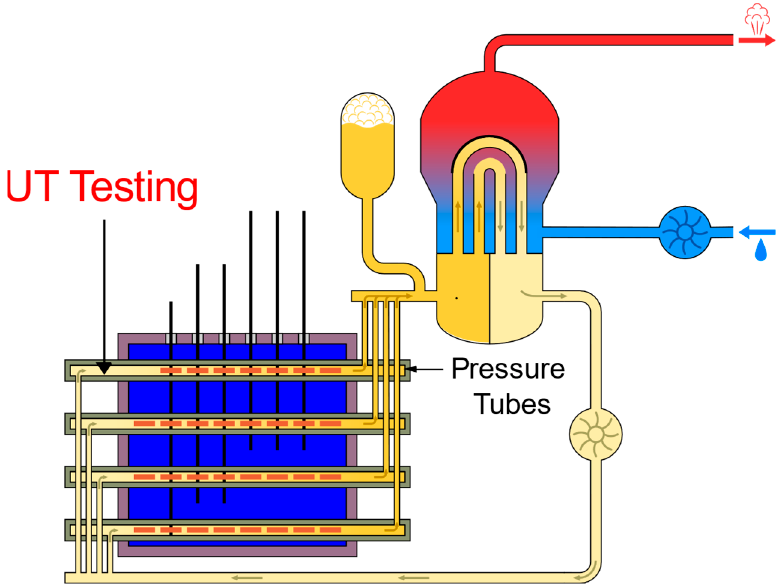
Figure 1. High-level design for the CANDU reactor core and the fuel channels.